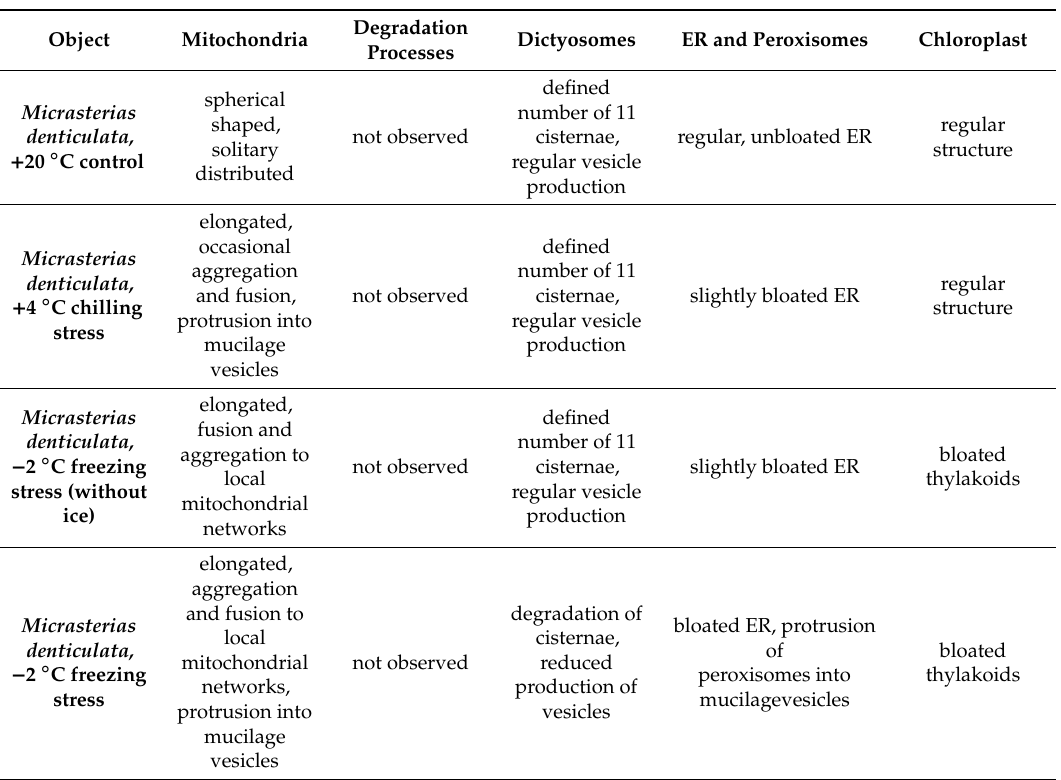
Table 1. Overview of most prominent ultrastructural alterations of organelles in Micrasterias, Lemna and R. glacialis during cold stress in comparison to untreated